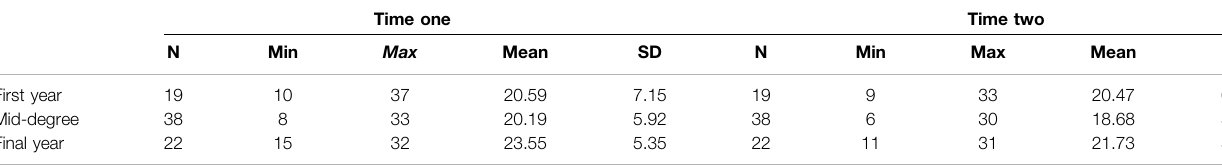
TABLE 5 | PSS Score Summary Time One and Time Two .